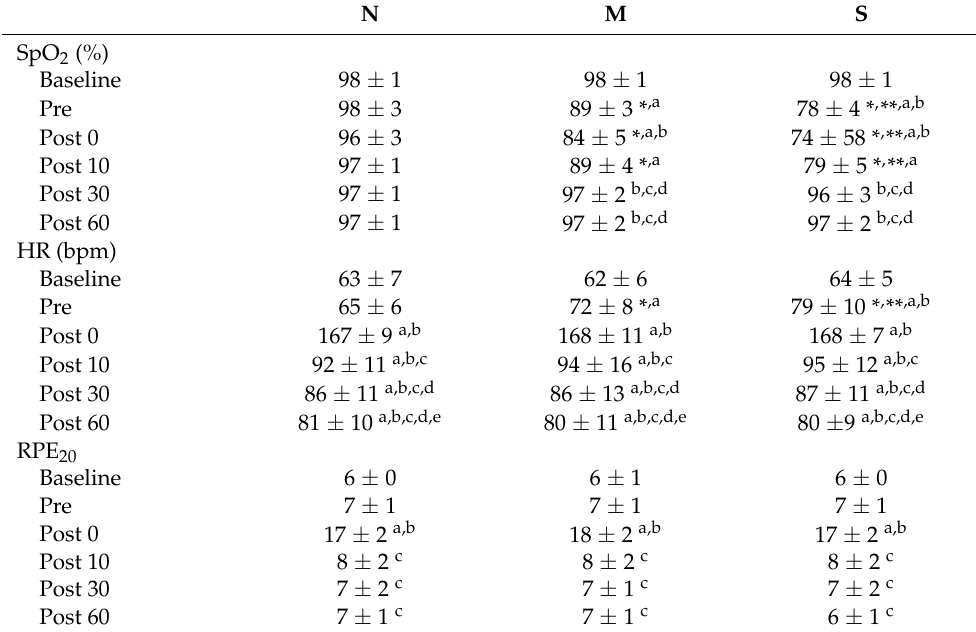
Table 1. Physiological responses before and after SIE in normoxia and